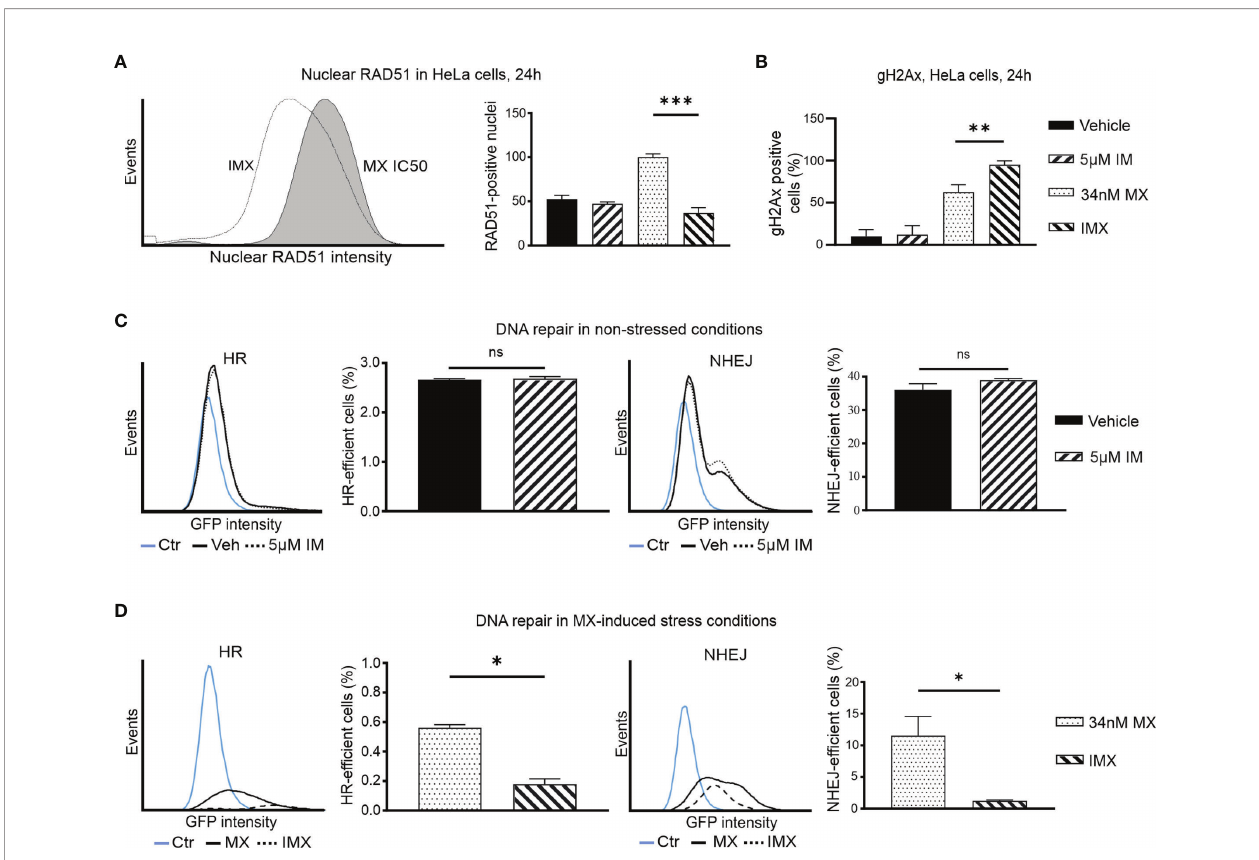
FIGURE 4 | IM decreases nuclear RAD51 level after DNA-damage and blocks DNA repair in cancer cells. (A) Histogram shows nuclear RAD51 intensity under 34 nM MX and 5 µM IM + 34 nM MX (IMX) treatment. The bar chart shows percent of nuclear RAD51 population after different treatments (95% CI of difference for MX vs . IMX: 47.49 – 82.51 where p = 0.0004, ordinary one-way ANOVA). (B) Bar chart shows percentage of g H2Ax-positive cells (95% CI of difference for MX vs . IMX: -54.26 to -10.56 where p = 0.0063, Ordinary one-way ANOVA). (C) The histograms show HR and NHEJ repair signal intensity, and bar chart shows percent of HR and NHEJ-ef fi cient cells (corrected against transfection ef fi ciency) after IM treatment in non-stressed conditions (95% CI of difference for HR: 5 µM IM vs . vehicle: -0.1189 – 0.1662 where p = 0.5499, NHEJ: 5 µM IM vs . vehicle: -2.764 – 8.630 where p = 0.1571, two-tailed, unpaired t-test). (D) The histograms show HR and NHEJ repair signal intensity, and bar chart shows percent of HR and NHEJ-ef fi cient cells (corrected against transfection ef fi ciency) after IM treatment in MX-induced stress conditions (95% CI of difference for HR: 5 µM IM vs . vehicle: -0.5037 to -0.2601 where p = 0.0054; NHEJ: MX vs . IMX: -19.49 to -1.139 where p = 0.0402, two-tailed, unpaired t-test). *p<0.05, **p<0.005, ***p=0.0001; ns, non-signi fi